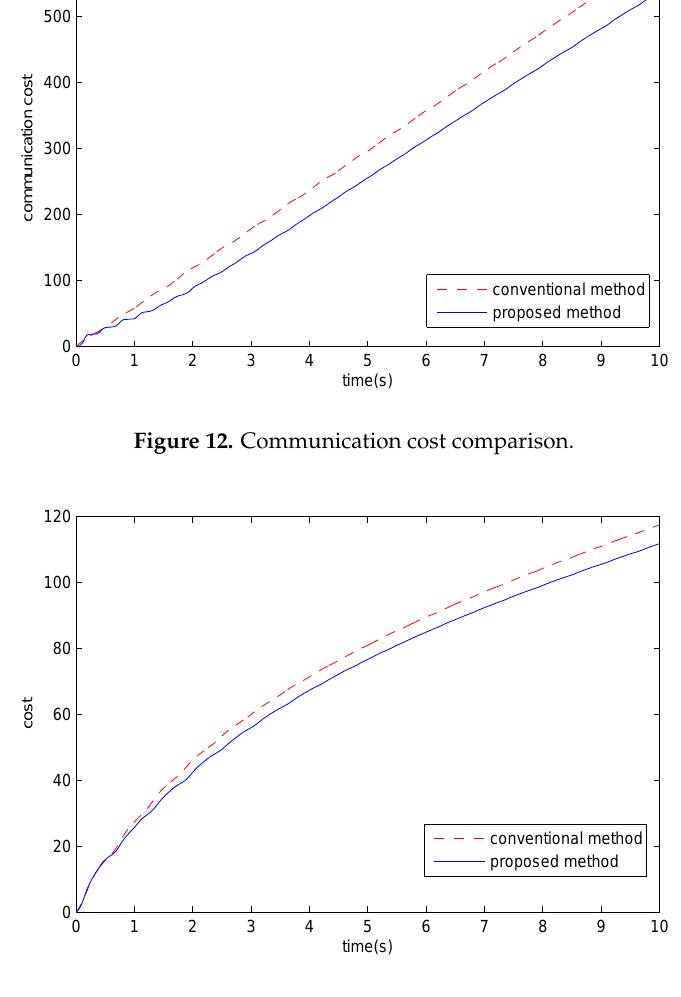
Figure 13. Cost curve